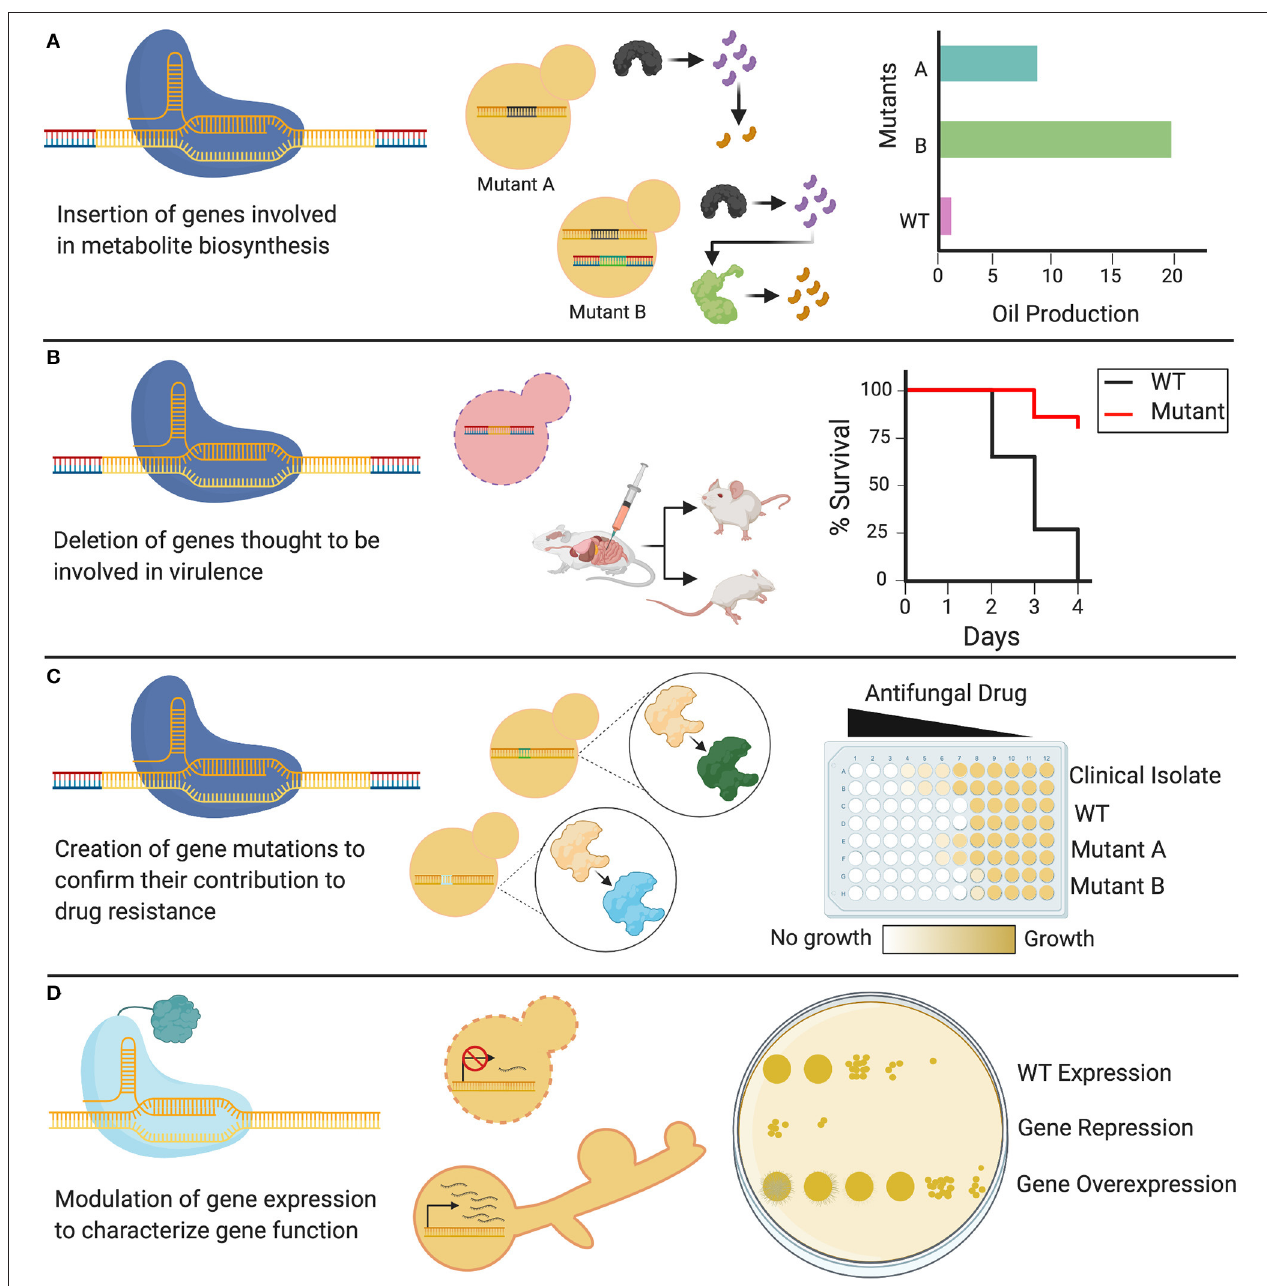
FIGURE 4 | Applications of CRISPR in Candida . Genetic modifications induced by CRISPR systems have diverse applications in Candida species. (A) Cas9 can be used to knock in heterologous genes that alter WT cellular metabolism by permitting new enzymes to create new biosynthetic products. (B) Cas9 can be used to delete genes of interest, generating knockout mutants of non-essential genes, which can be used to identify the role of these genes in fungal virulence. (C) CRISPR systems can be used to introduce targeted genetic mutations through codon or base-level changes. These genetic variants can be assessed to identify the role of specific targeted mutations in resistance to antifungal drugs. (D) dCas9 can be used to either repress or overexpress a gene depending on the transcriptional domain fused to it, allowing for the study and phenotypic characterization of Candida genes, including essential